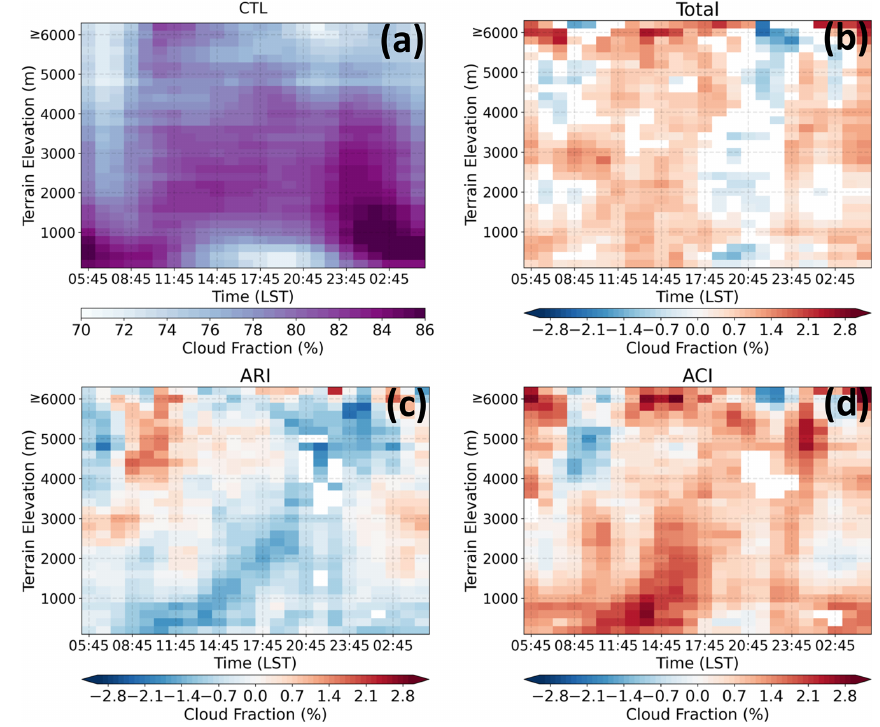
Figure 11. Elevation-dependent cloud fraction for (a) CTL, (b) aerosol effect (CTL–CLEAN), (c) ARI effect (CTL–NoARI), and (d) ACI effect (NoARI–CLEAN) and their diurnal variability. Only the differences that are significant at the 90% confidence level based on the Student t test are